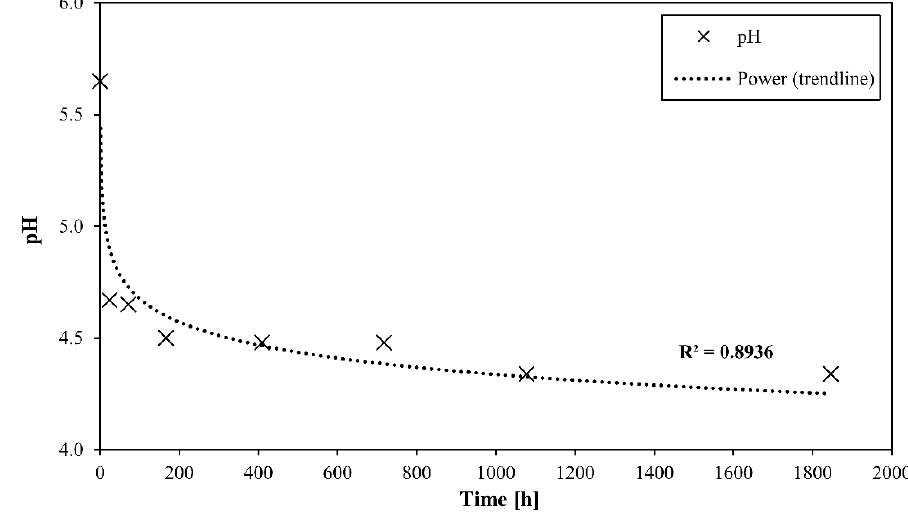
Figure 7. pH measurements of distilled water samples after contact with the resin.